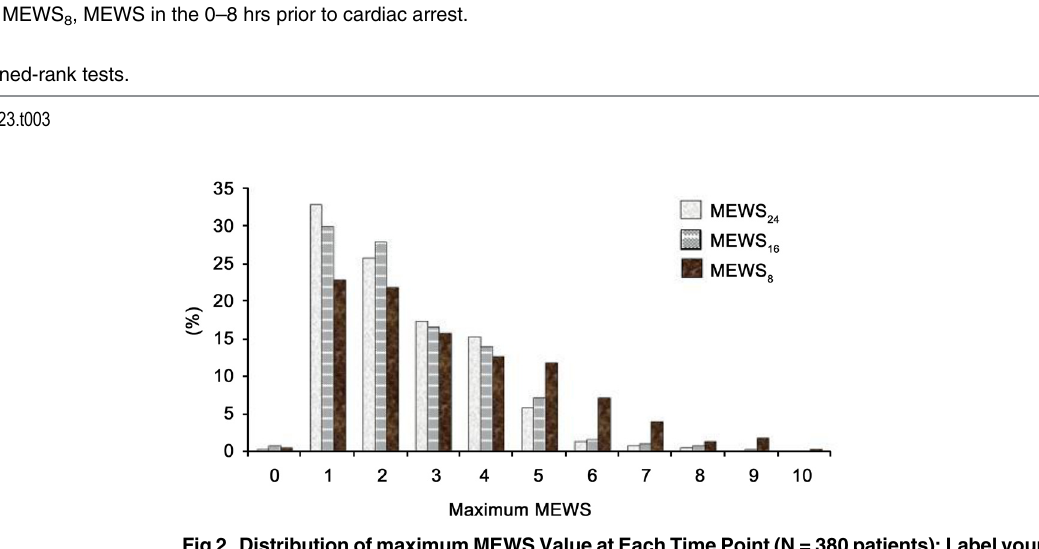
Fig 2. Distribution of maximum MEWS Value at Each Time Point (N = 380 patients); Label your vertical axis (% Patients) Label your horizontal axis as Maximum MEWS score.